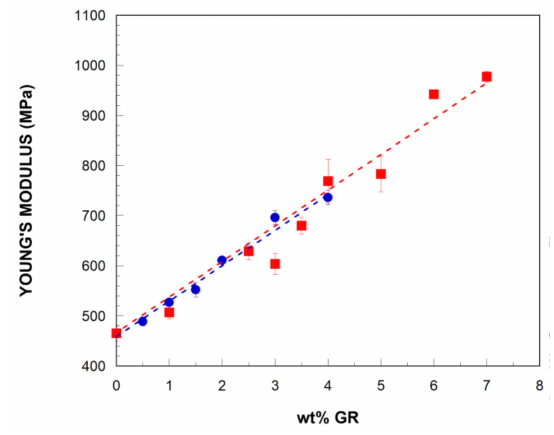
Figure 5. Young’s modulus of the bTPU/GR ( (cid:4) ) and bTPU/GR-IL ( • ) NCs as a function of the GR